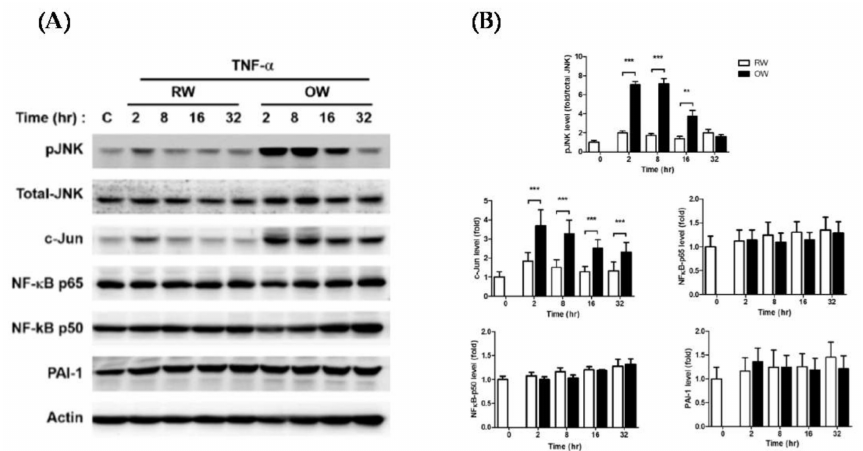
Figure 2. E ff ects of oxygenated water on inflammatory signaling and oxidative stress in mature adipocytes. 3T3-L1 mature adipocytes were pre-incubated in serum-free medium for 3 h, then treated with either OW or RW and 10 ng / mL of TNF- α for di ff erent time intervals. ( A ) Protein expression profiles of molecules involved in pro-inflammatory signaling were analyzed and quantified ( B ). Data are presented as mean ± S.E.M. ( n = 4) and were statistically analyzed by two-tailed unpaired Student t-tests; ** p < 0.01, *** p <